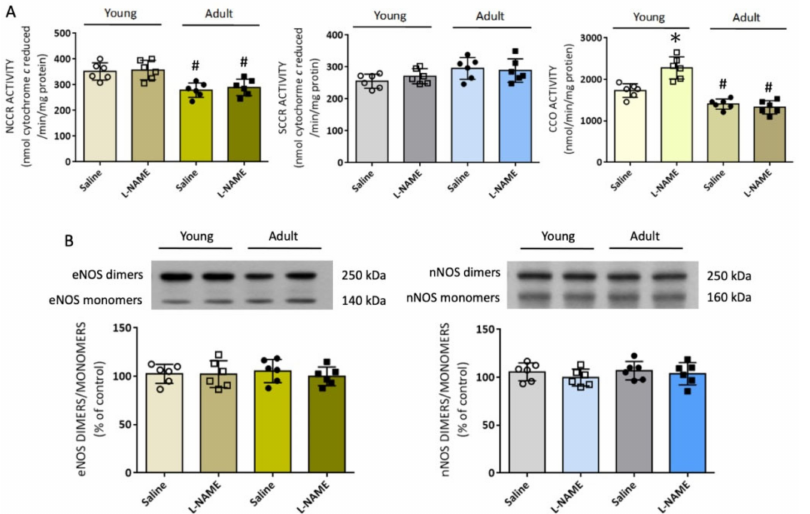
Figure 5. Effect of systemic L -NAME treatment on mitochondrial electron transport chain enzyme activity and NO synthase (NOS) uncoupling in RVLM: ( A ) Enzyme activities of NADH cytochrome c reductase (NCCR, marker for coupling capacity between complexes I and III), succinate cytochrome c reductase (SCCR, marker for coupling capacity between complexes II and III), and cytochrome c oxidase (CCO, marker for complexes IV) in RVLM of young (8 weeks, open circles or squares) or adult (20 weeks, filled circles or squares) rats after i.p. infusion of saline or L -NAME (10 mg/kg/day). ( B ) Representative gels (insets) and densitometric analysis of results from Western blot showing changes in the ratio of dimers versus monomers of eNOS and nNOS protein in RVLM of young and adult rats after saline or L -NAME treatment. Data on protein expression were normalized to the respective saline control value, which is set to 100%. Data are presented as mean ± SD, n = 6 per group. * p < 0.05 versus corresponding saline-treated group, and # p < 0.05 versus saline-treated young rats in unpaired Student’s t